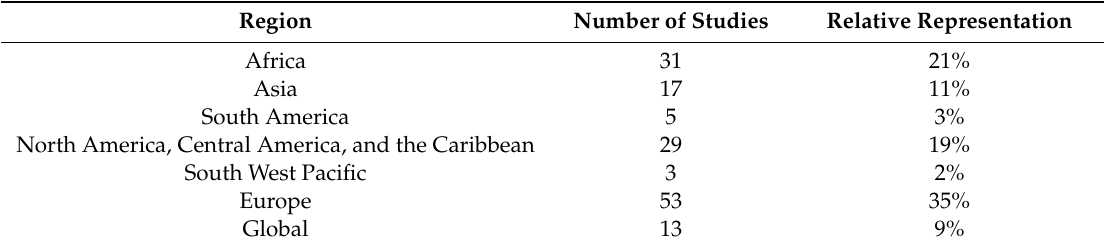
Table 3. Regional focuses of studies ( n =